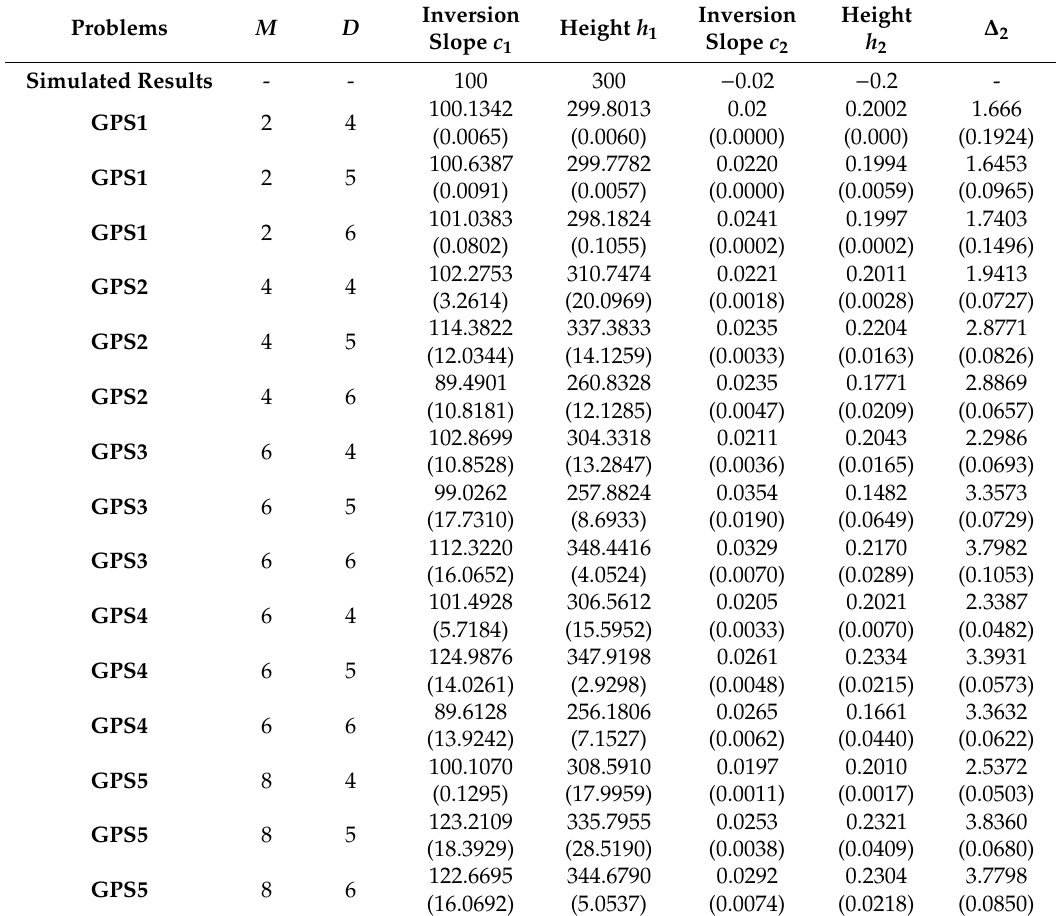
Table 4. Statistical results of the retrieved parameter values and ∆ 2 metric in di ff erent problems (mean and